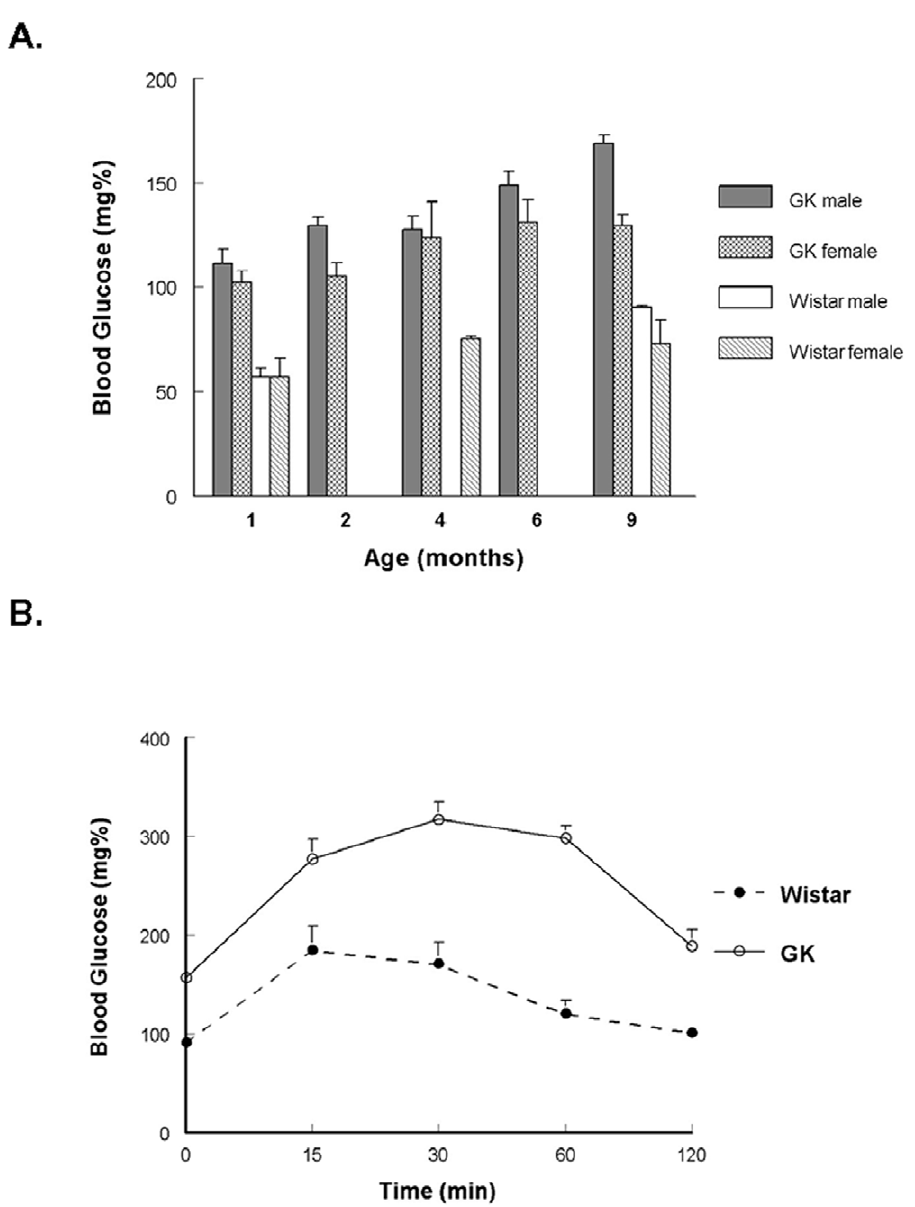
Figure 1. GK rats are hyperglycemic. A. Fasting blood glucose from GK and Wistar rats at indicated ages. Samples taken in morning after overnight fast of 16 hours. Values are mean 6 SEM of 3 to 8 animals. B. GK rats have impaired glucose tolerance. Animals were anesthetized with Nembutal (40 mg/kg, i.p. ). Glucose was injected (1.0 mg/kg i.p. ) and blood glucose determined at select intervals. Area under the curve (AUC) analysis determined that the GK was significantly (p , .05) increased compared to Wistar following injections (Goto-Kakzaki:12631 6 1191 n=8, Wistar: 4902 6 1247 n=9 AUC arbitrary units).